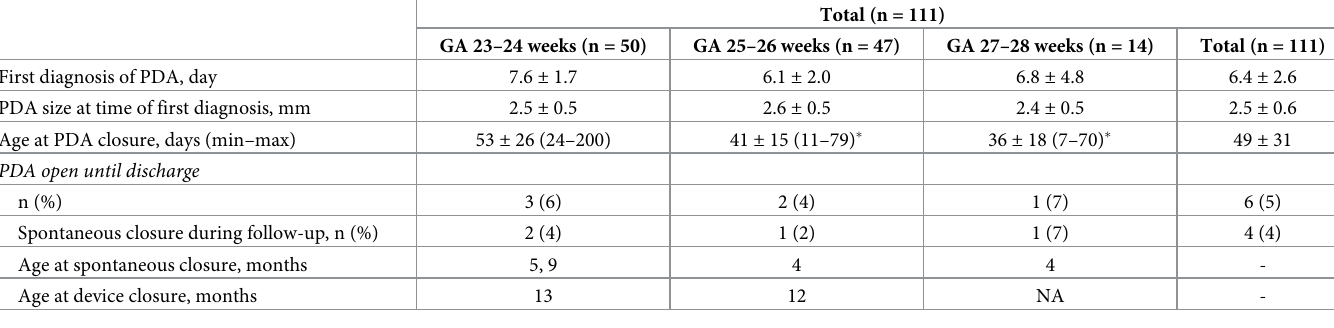
Table 1. Characteristics of HS PDA according to gestational age